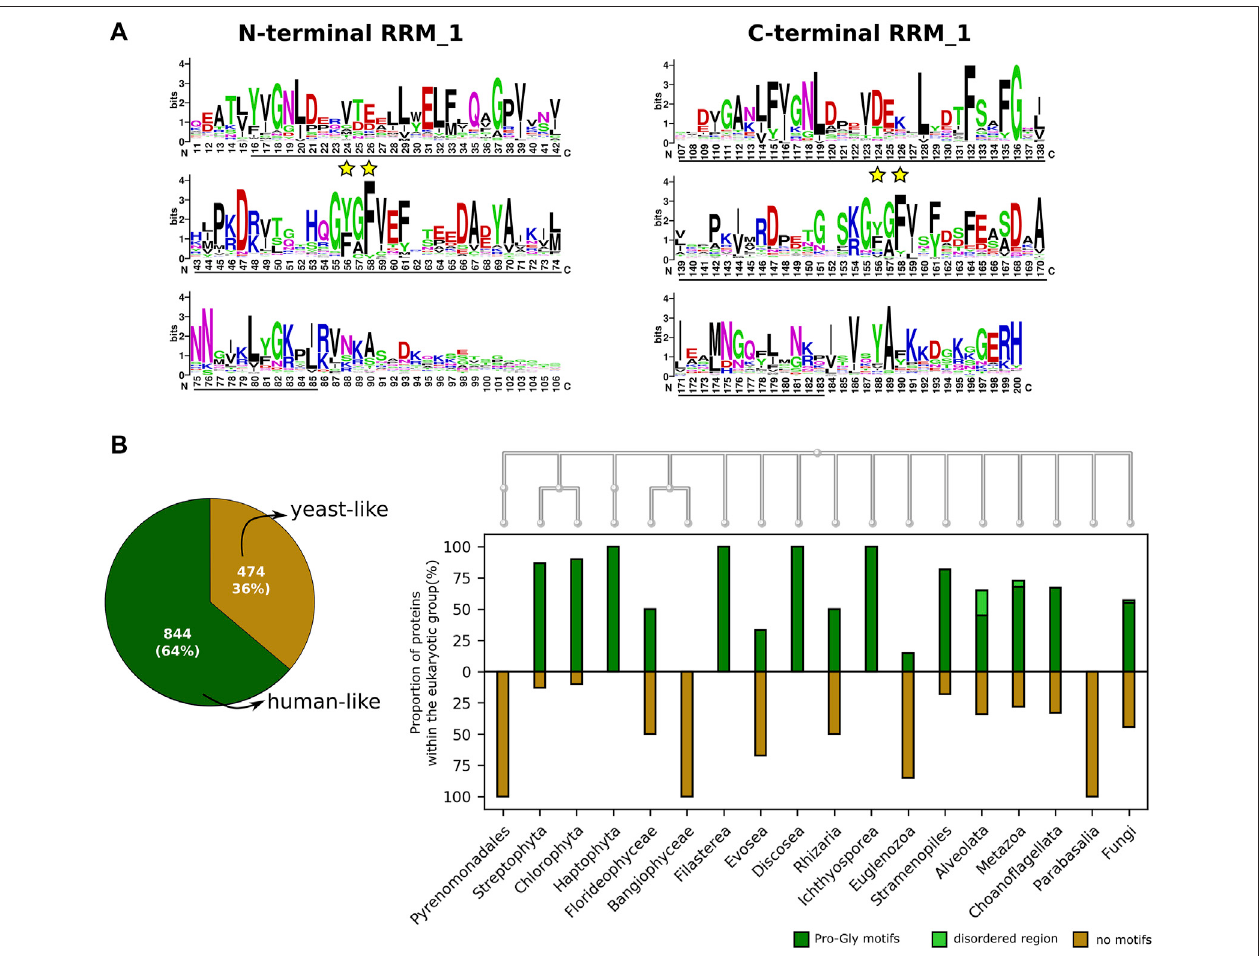
FIGURE 4 | The conservation of functional sites in the SF3b4. (A) Shown is the sequence logo of the conservation of SF3b4 protein across eukaryotes. Black underlines highlight RRM_1 domain regions at the N- and C-terminus. Yellow stars indicate the functional sites in RNP motifs. The N- and C-terminal RRM motifs show distinctconservationpro fi les. (B) PlottedistheVenndiagramthatindicatestheoverallpercentageofhomologshavingrecognizablemotifsattheC-terminus(human-like, dark green) and homologs having no motifs at the C-terminus (yeast-like, gold). To the right, the bar plot shows the proportion of SF3b4 homologs in which the C-terminal has proline-rich motifs (dark green), disordered region (light green), or no recognizable motifs (gold). Along the x -axis phylogenetic links among the kingdoms having SF3b4 homologs are shown as cladogram, drawn using the NCBI Tree Viewer (https://www.ncbi.nlm.nih.gov/projects/treeview/).